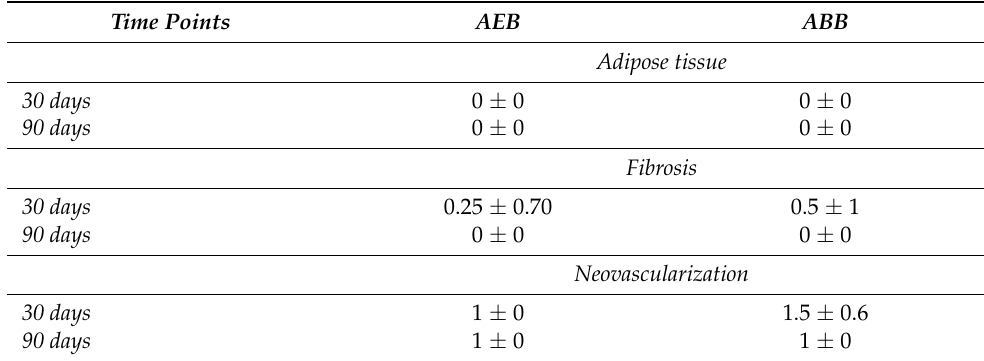
Table 3. Average histological scores of soft tissue response in AEB and ABB